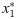
Encryption key sensitivity showed by Lena.(a) cipher of Lena; (b) cipher of Lena with key x1* changed 10−15.